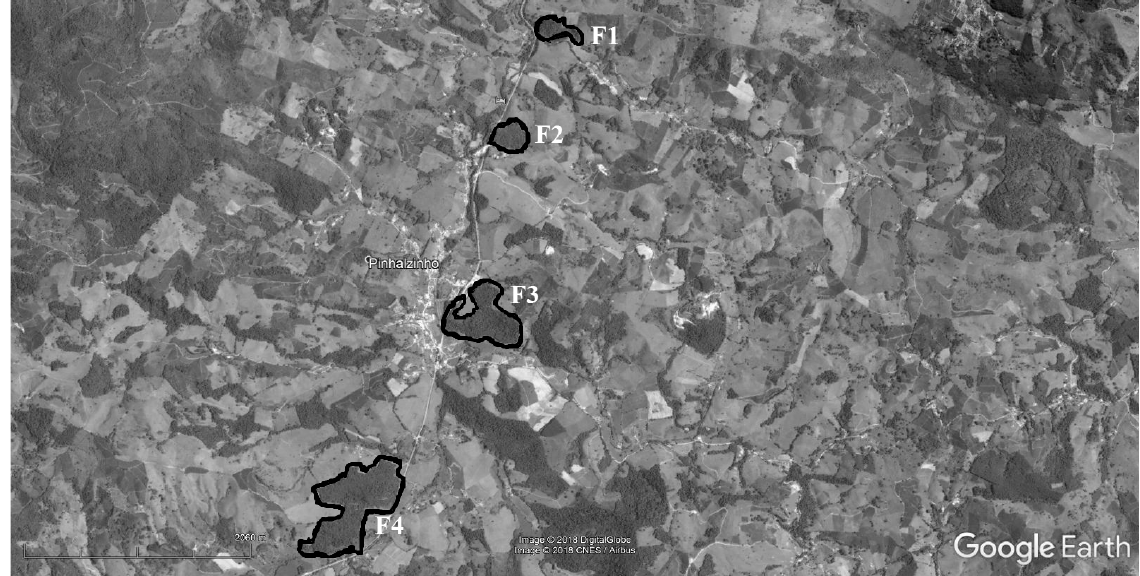
Fig 1 . Location of the Montane Semideciduous Seasonal Forest fragments used to evaluate the impact of fragmentation on the social wasps’ communities in the south side of the state of Minas Gerais, in the Southeast region of